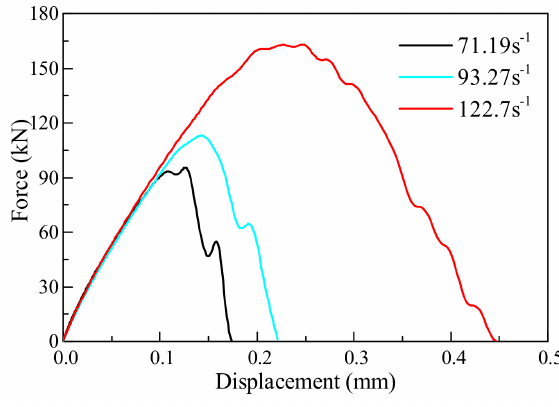
Figure 9. Force-displacement curves of concrete subjected to different strain